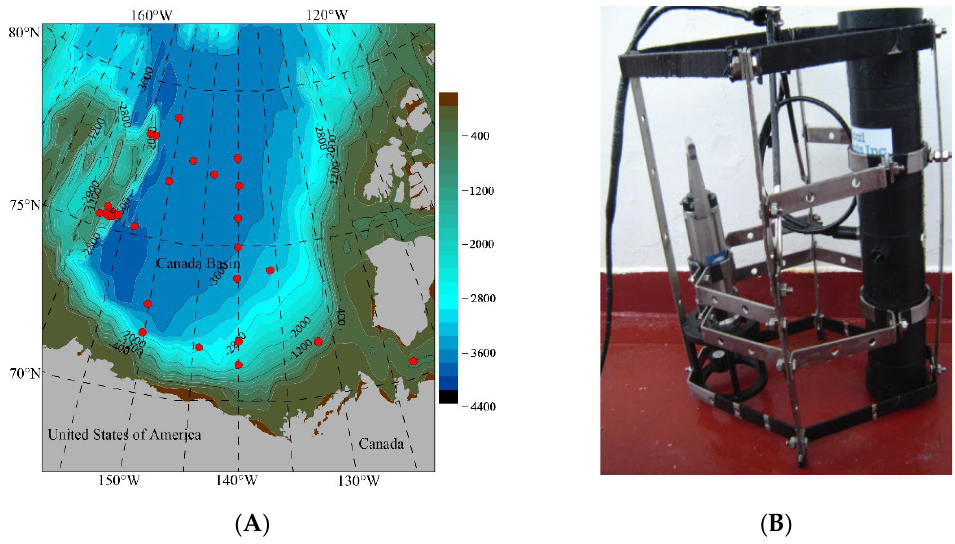
Figure 1. ( A ) Station map for the 2006 Canada Joint Ocean-Sea Study Science Program. The red dots represent the observation stations. ( B ) Optical observation instruments. The right black cylinder is the PRR800, and the left silver instrument is the MCTD.